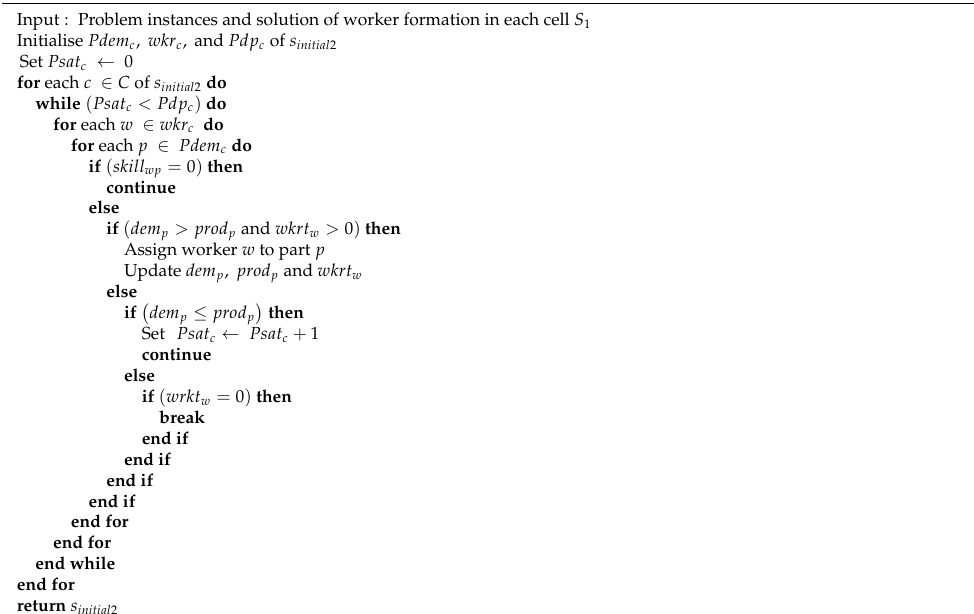
Algorithm 3 Stage2 initial